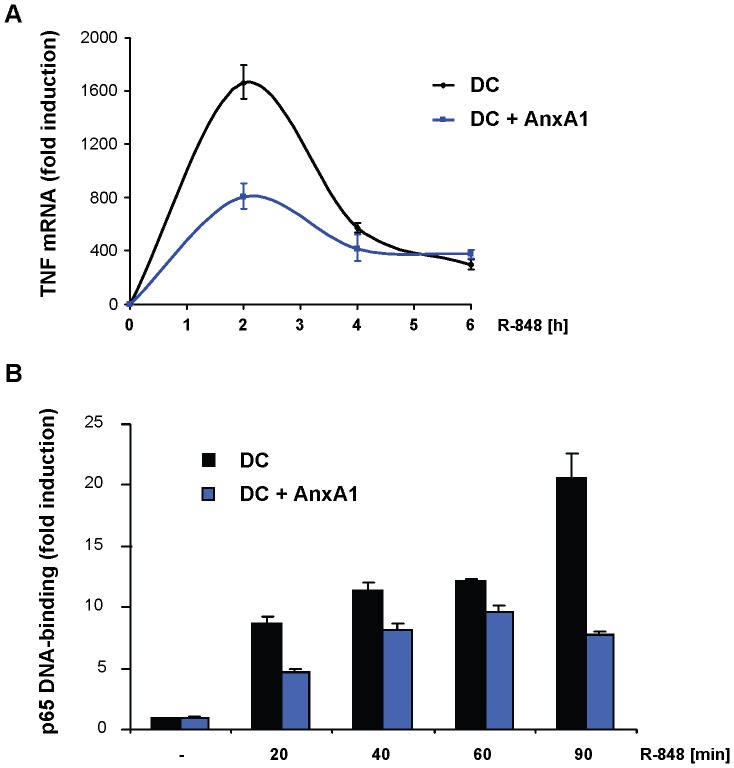
Annexin A1 inhibits TLR-induced signal transduction pathways.(A) Immature DC were incubated with annexin A1 (AnxA1, 20 µg/ml) or left untreated. Subsequently, DC were stimulated with R-848 (1 µg/ml) for the indicated time periods. TNF mRNA expression was determined by reverse transcription quantitative PCR normalized to GAPDH. Fold change was calculated relative to unstimulated DC (set to 1). Data are representative of at least 3 independent experiments. (B) Immature DC were treated as in (B). DNA binding of the NF-κB subunit p65 was analyzed in nuclear extracts of DC by ELISA. Error bars represent means +/− SD of duplicate measurements. Data are representative of 2 independent experiments.